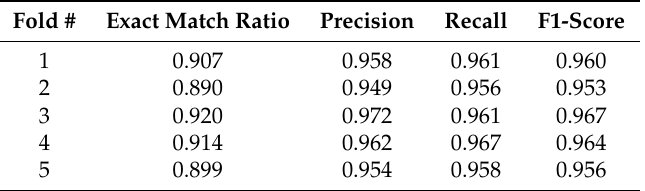
Table 2. Aggregate performance of the five models, one for each